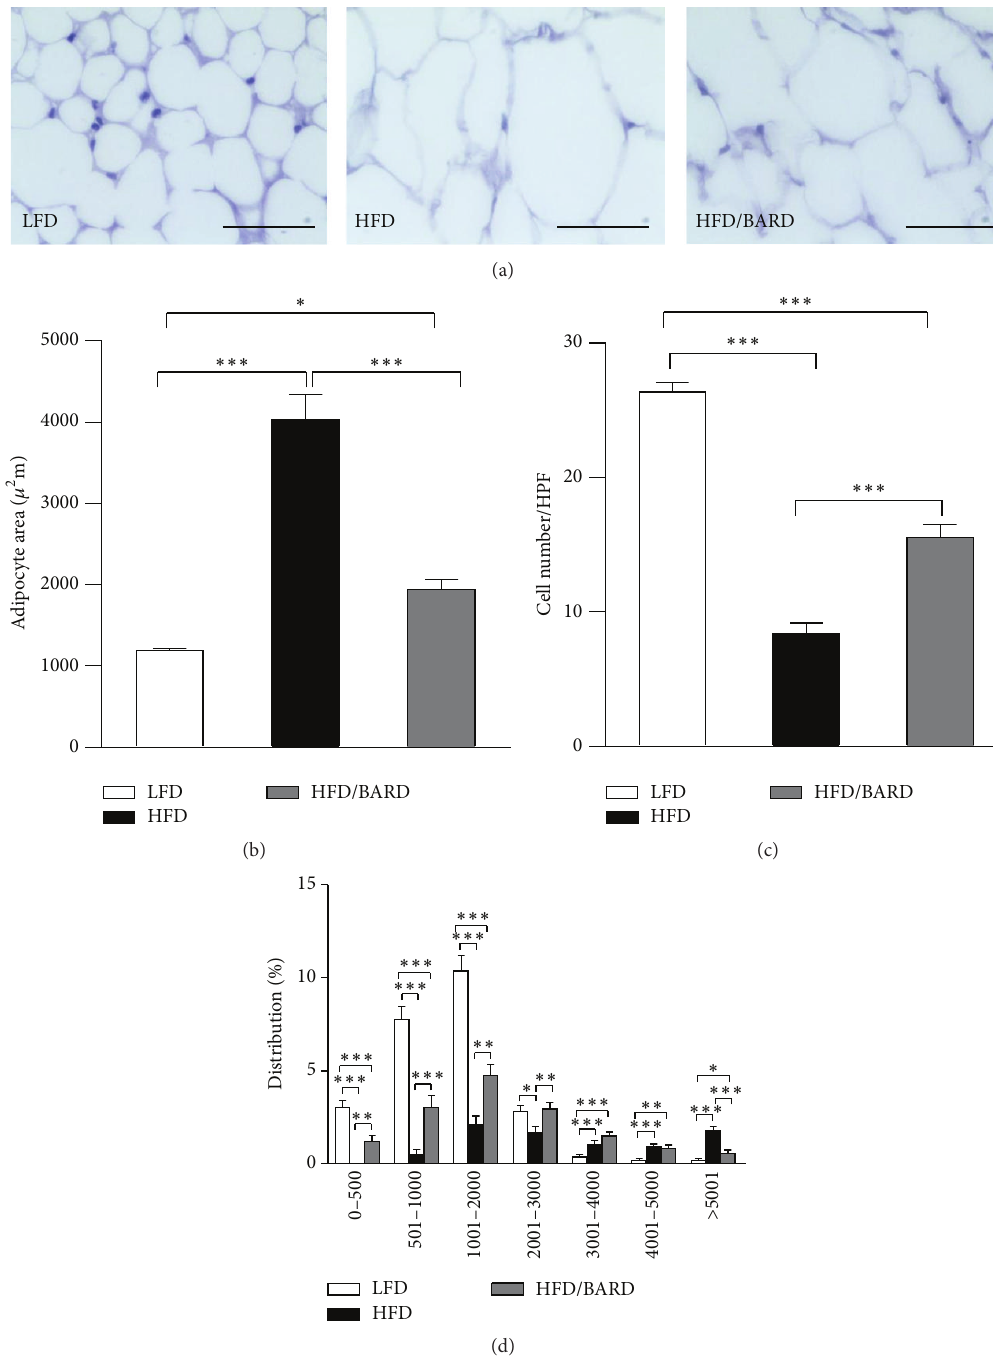
Figure 1: Effect of bardoxolone methyl (BARD) on mesenteric fat deposition of mice fed low-fat diet (LFD), high-fat diet (HFD), and high- fat diet supplemented with BARD (HFD/BARD). (a) Haematoxylin and eosin stained sections ( × 40). Bar = 50 𝜇 m. (b) Mesenteric adipocyte area. (c) Number of cells per high power field (HPF). (d) Distribution of adipocyte size. All data are presented as mean ± SEM. ∗ 𝑝 < 0.05 ; ∗∗ 𝑝 < 0.01 ; ∗∗∗ 𝑝 < 0.001